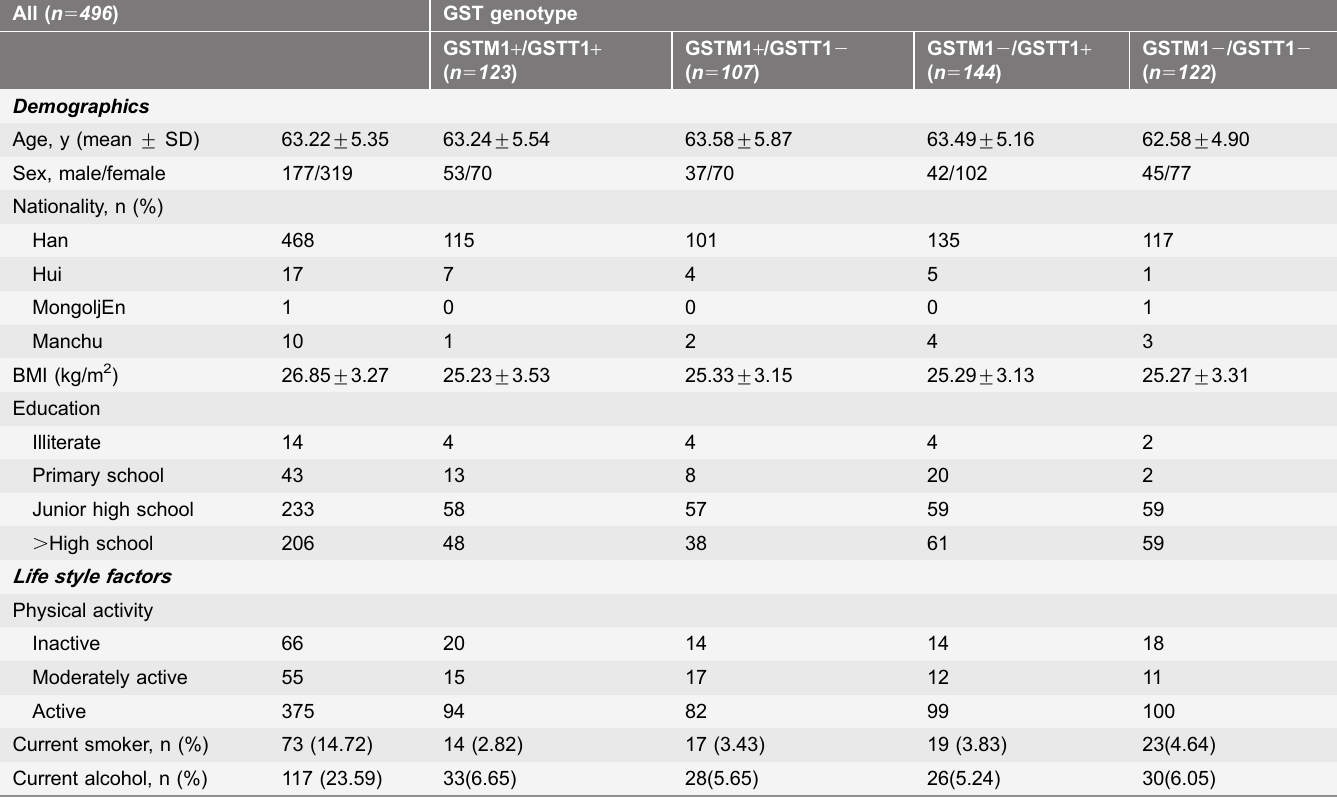
Table 1. Unadjusted demographic characteristics of the